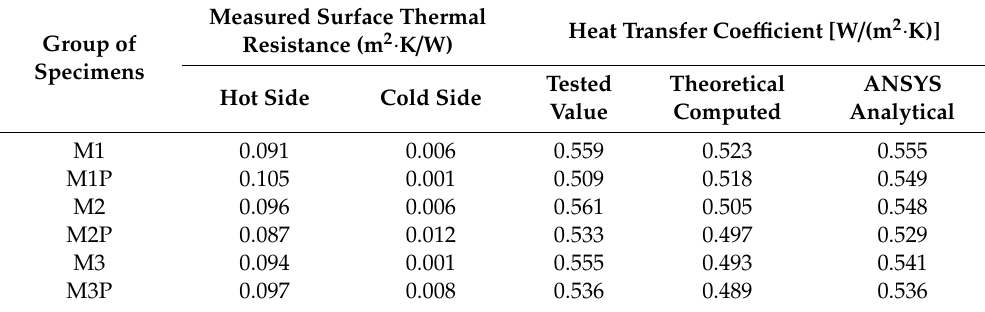
Table 6. Test results and analytical results for thermal transfer of AAC block masonry.